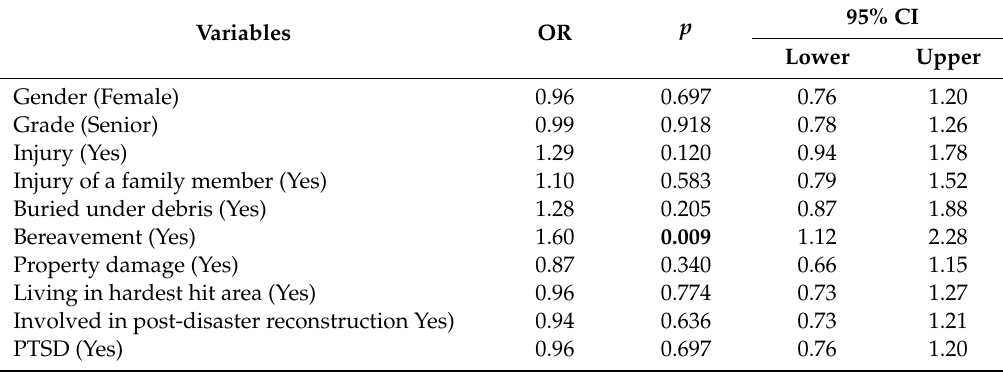
Table 5. Logistic regression analyses on the associations between independent variables and PTSD ( N = 1976). 95% CI Variables OR p Lower Upper Gender (Female) 0.96 0.697 0.76 1.20 Grade (Senior) 0.99 0.918 0.78 1.26 Injury (Yes) 1.29 0.120 0.94 1.78 Injury of a family member (Yes) 1.10 0.583 0.79 Buried under debris (Yes) 1.28 0.87 1.88 Bereavement (Yes) 0.009 Property damage (Yes) 0.87 0.340 0.66 1.15 Living in hardest hit area (Yes) 0.96 0.774 0.73 1.27 Involved in post-disaster reconstruction Yes) 0.94 0.636 0.73